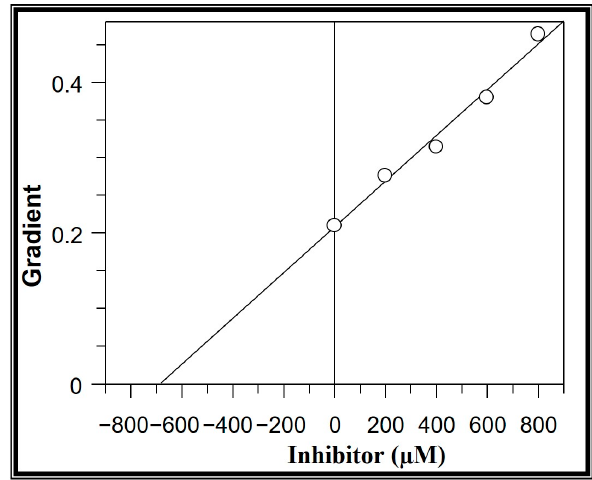
Figure 5. Lineweaver–Burk plot of gradient vs different concentrations of 1.